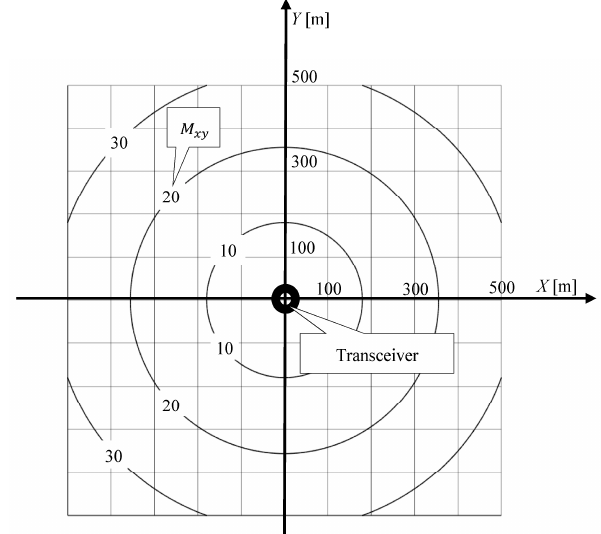
Figure 3. Mapping the accuracy of the coordinate position of determined USBL system (describes mean error M xy in meters).